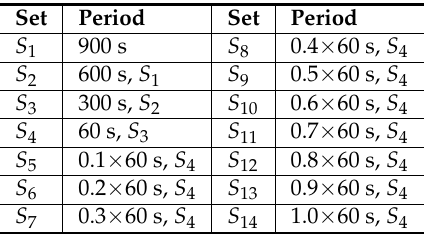
Table 2. Scenario 1 evaluation SmartData